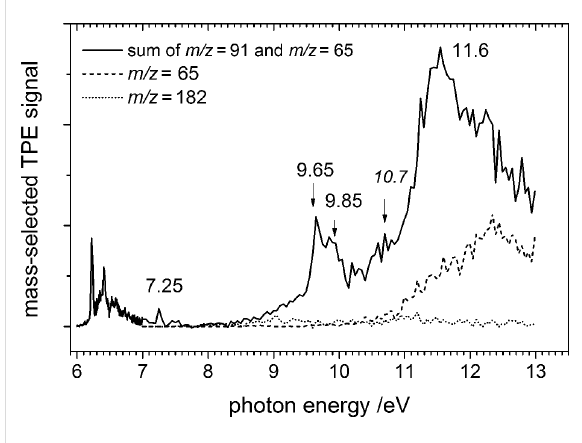
Figure 4: TPE spectrum of tropyl (solid line) and cyclopentadienyl ( m / z = 65, dashed line) in the 7–13 eV photon energy range. Since C 5 H 5+ is generated by dissociative photoionisation of tropyl at higher energies, the tropyl photoelectron spectrum is displayed as the sum of the two mass channels. The residual signal at the mass of the precursor is given as a dotted line for comparison.